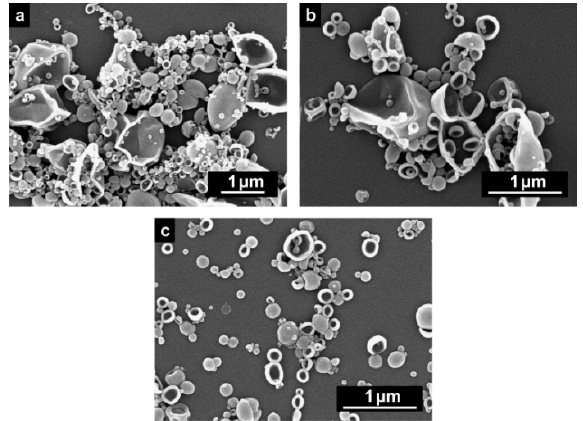
Figure 3. SEM images of PU NCs prepared using different continuous: aqueous phase ratios: ( a ) 70%:30%, ( b ) 80%:20 %, and ( c ) 85 %:15